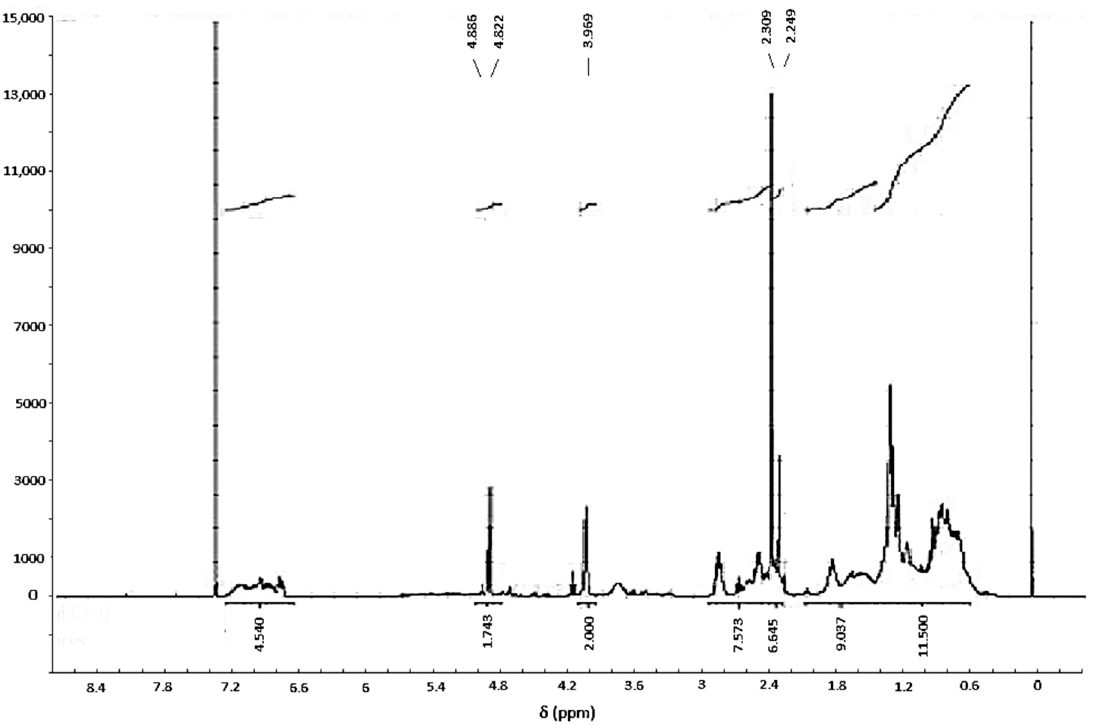
Figure 5. 1 H-NMR spectrum of the DEM1 substance.